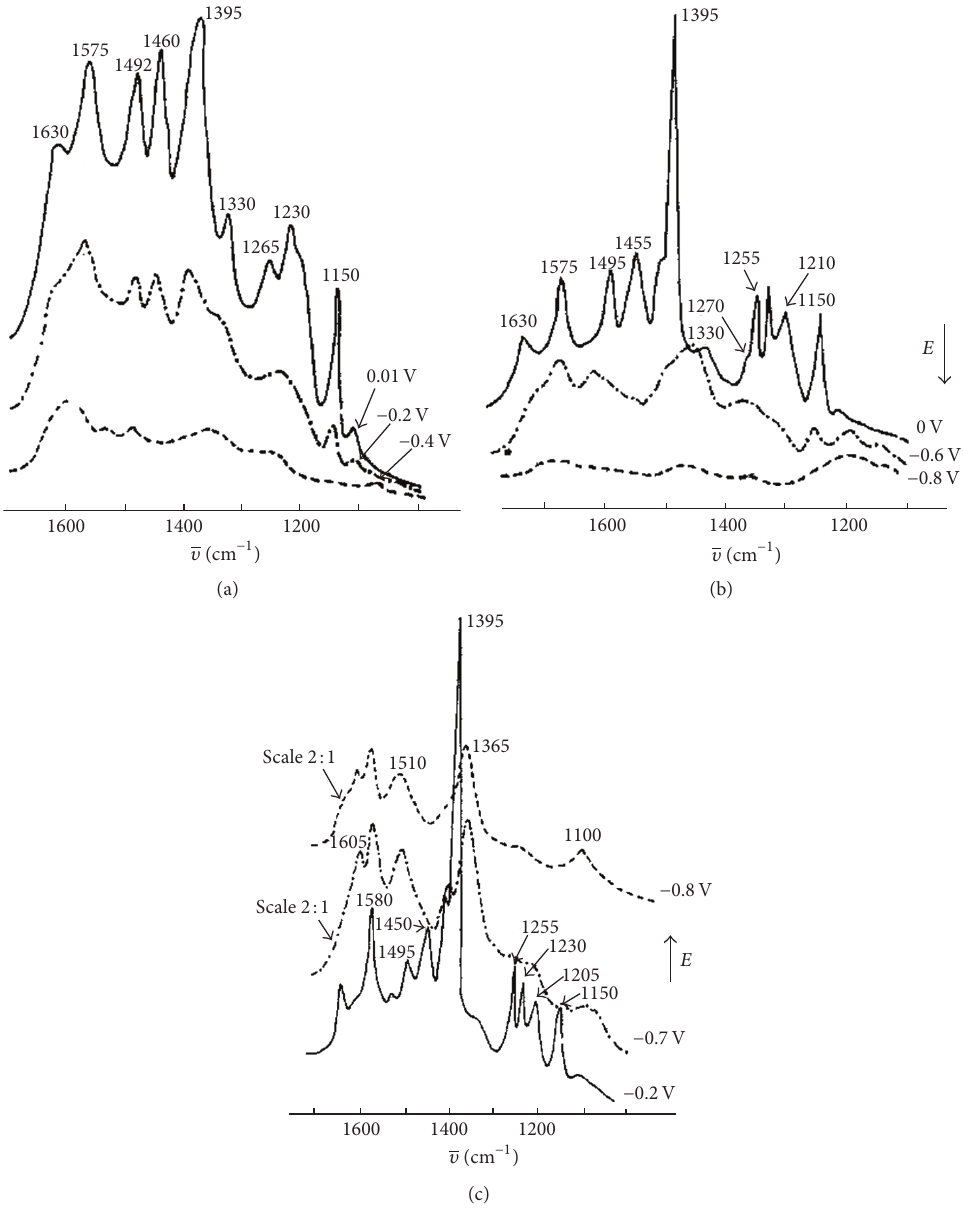
F 23: SERS spectra of o -AP solutions at (a) pH 3.0, (b) pH 7.5, and (c) pH 9.7, for different electrode potentials